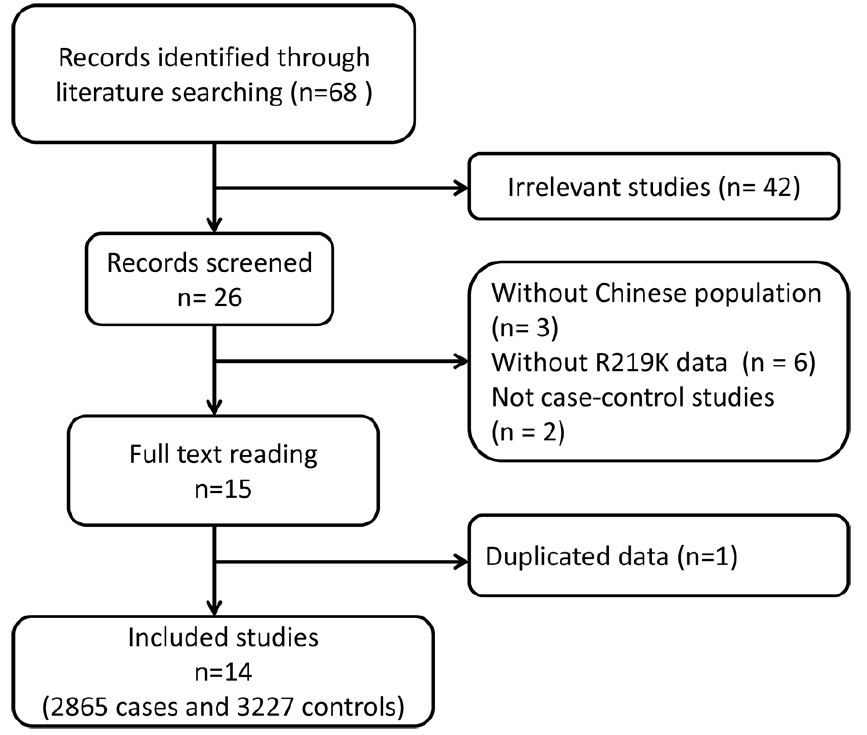
Figure 1: The flow diagram of the selection process for the